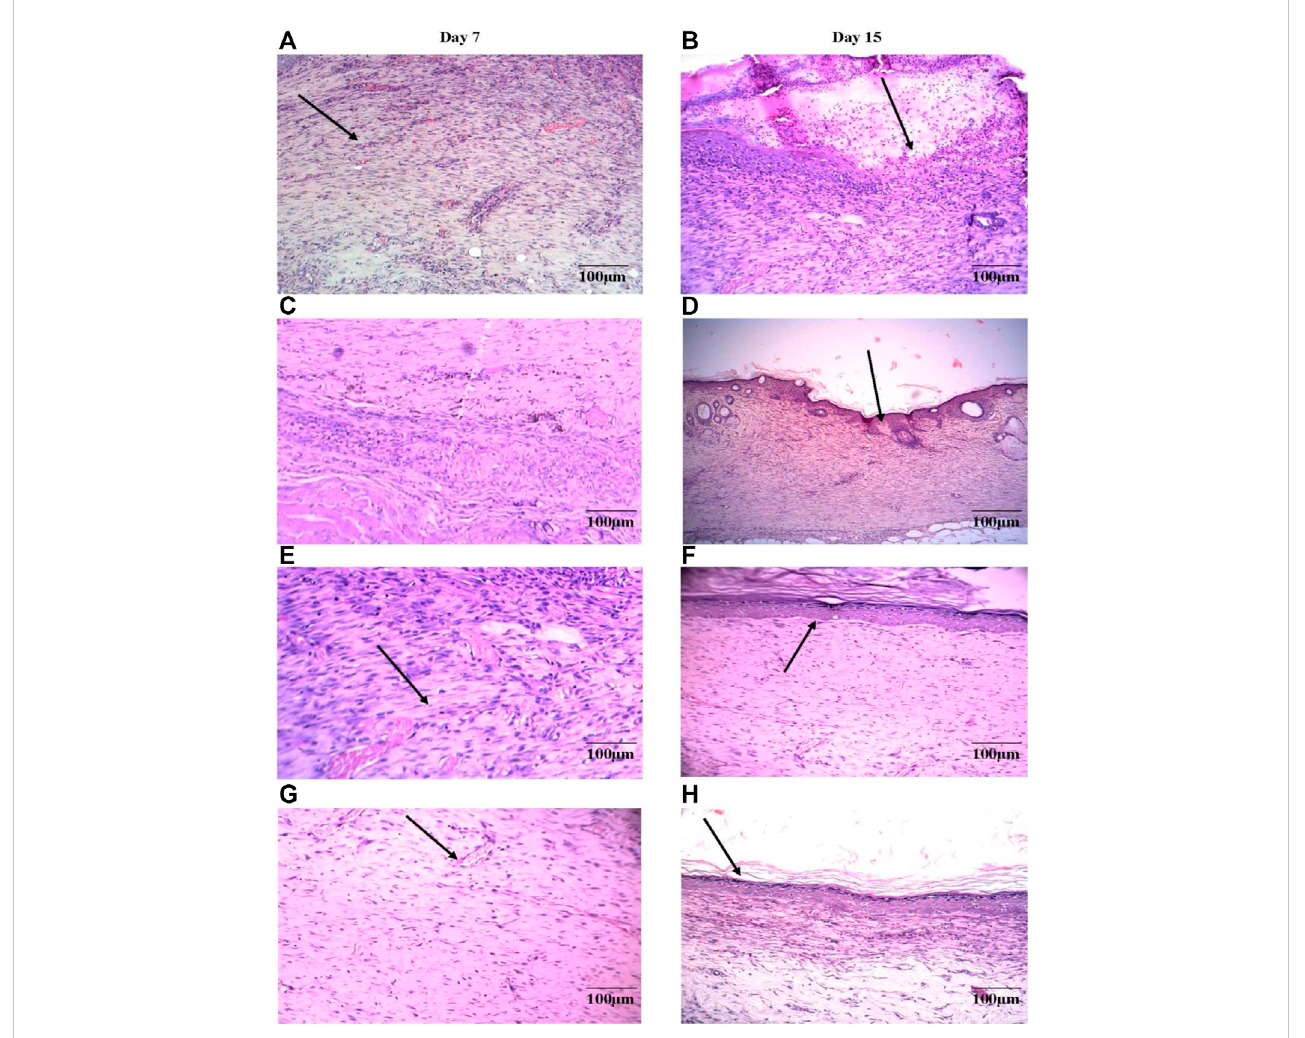
FIGURE 7 Histologicalevaluationof7 th and15 th postoperativedaywoundskinsectionsstainedwithhematoxylinandeosin(Bar=100 μ m).Controlgroup[ (A) on7 th Dayand (B) on15 th Day],Standardtreatmentgroup[ (C) on7 th Dayand (D) on15 th Day],2.5%w/wDVFOtreatmentgroup[ (E) on7 th Dayand (F) on15 th Day],5% w/w DVFO treatment group [ (G) on 7 th Day and (H) on 15 th